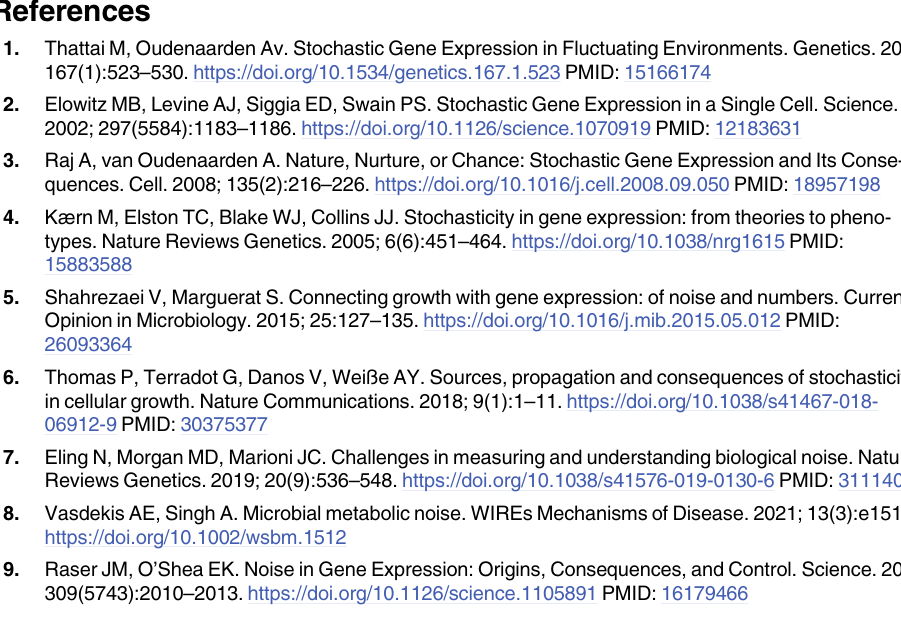
S6 Fig. Examination of the sensitivity of the positive scaling. ϕ versus κ for kinotype 2 around the evolved genotype (black circle) in the high noise regime ( F = 10). Grey dots denote mutant genotypes, for which their mean growth rate (relative to the mean growth rate of the evolved genotype) is plotted against the correlation coefficients of ϕ and κ for that particular genotype. Mutants are created by three different methods: (1) mutation in a single protein with a normally distributed step size with standard deviation 15% (40 genotypes, plus-sign markers), (2) with 5% (30 genotypes, diamond-sign markers), and (3) mutations in all protein species with standard deviation 5% (30 genotypes, square-sign markers). After the mutations, genotypes were re-normalised to make sure total cell size, and ϕ remained constant. H S1 Table. Kinetic parameters of the example kinotype. Catabolic rate ( k ) and inhibition cat constant ( k ) for the five metabolic protein species in the kinotype used to create figure Figs inhi 2 and S4. Additionally, the initially sampled (relative) protein abundances are given.